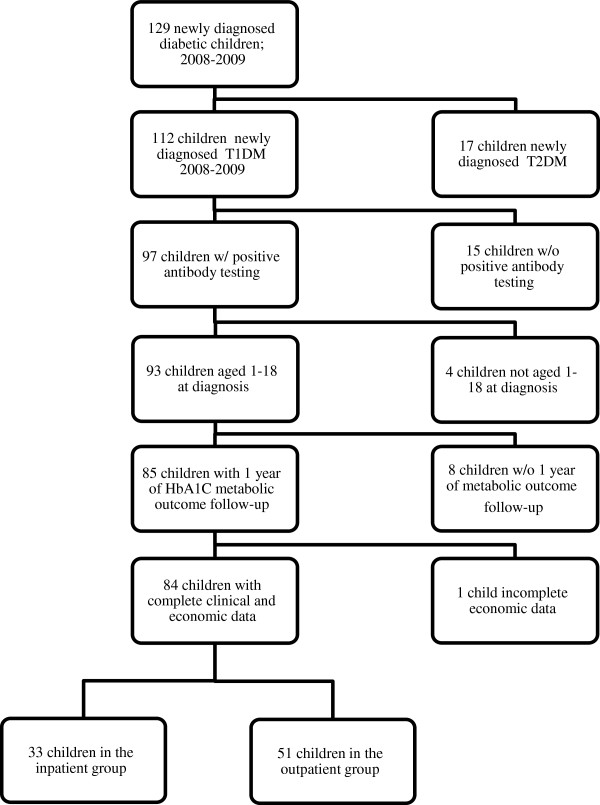
Flow diagram of the study population.